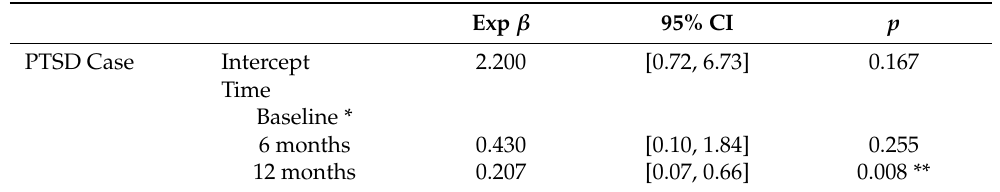
Table 6. General Estimating Equation Statistics for PTSD Case. Exp β 95% CI p PTSD Case Intercept 2.200 [0.72, 6.73] 0.167 Time Baseline * 6 months 0.430 [0.10, 1.84] 0.255